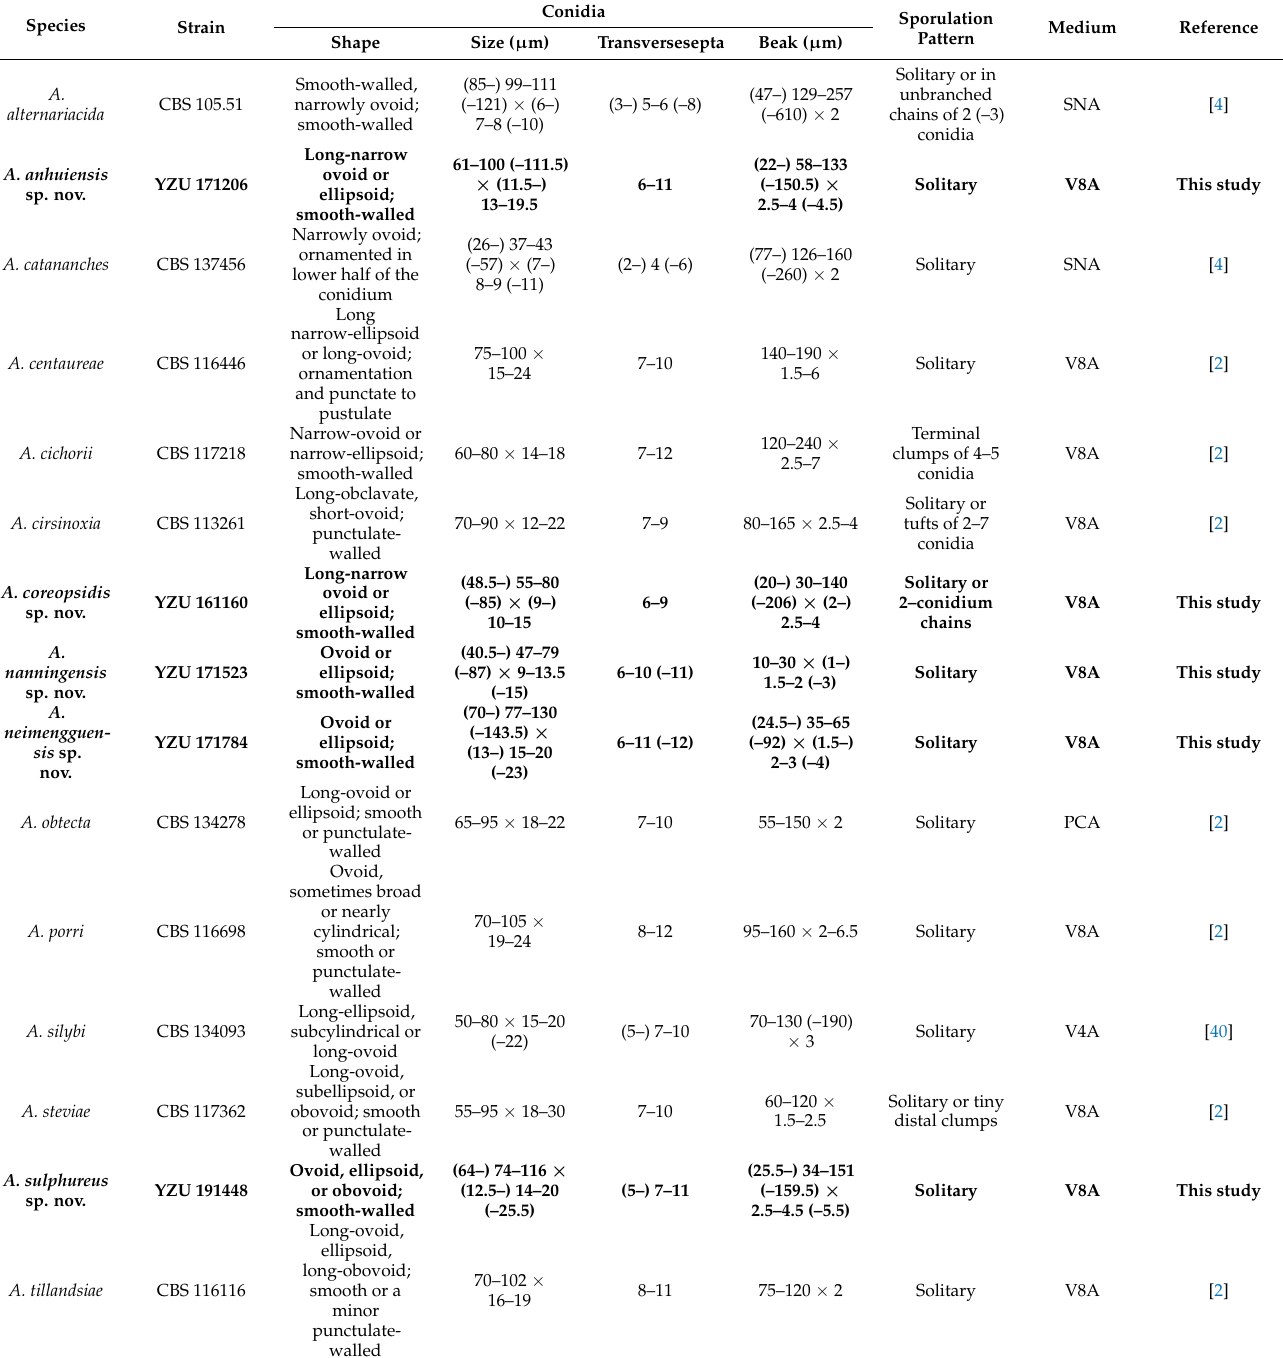
Table 2. Morphological comparisons of the five new Alternaria species and their closely related